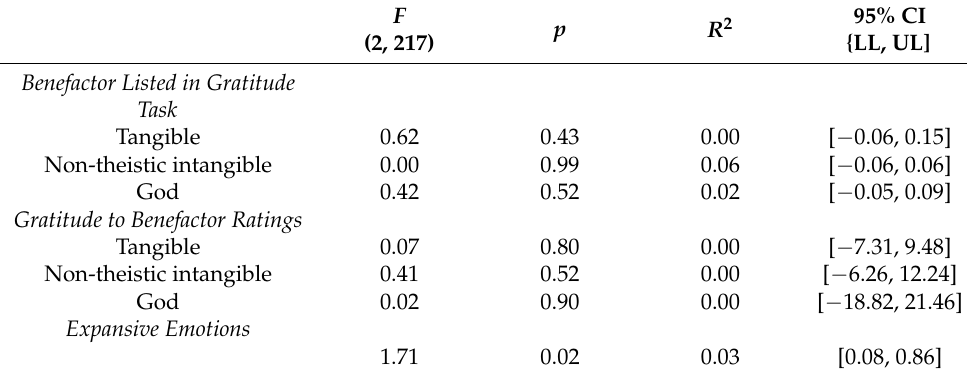
Table 2. Hypothesis 2: High trait construal levels predicting the proportion of types of benefactors in benefactor lists, gratitude ratings, and expansive